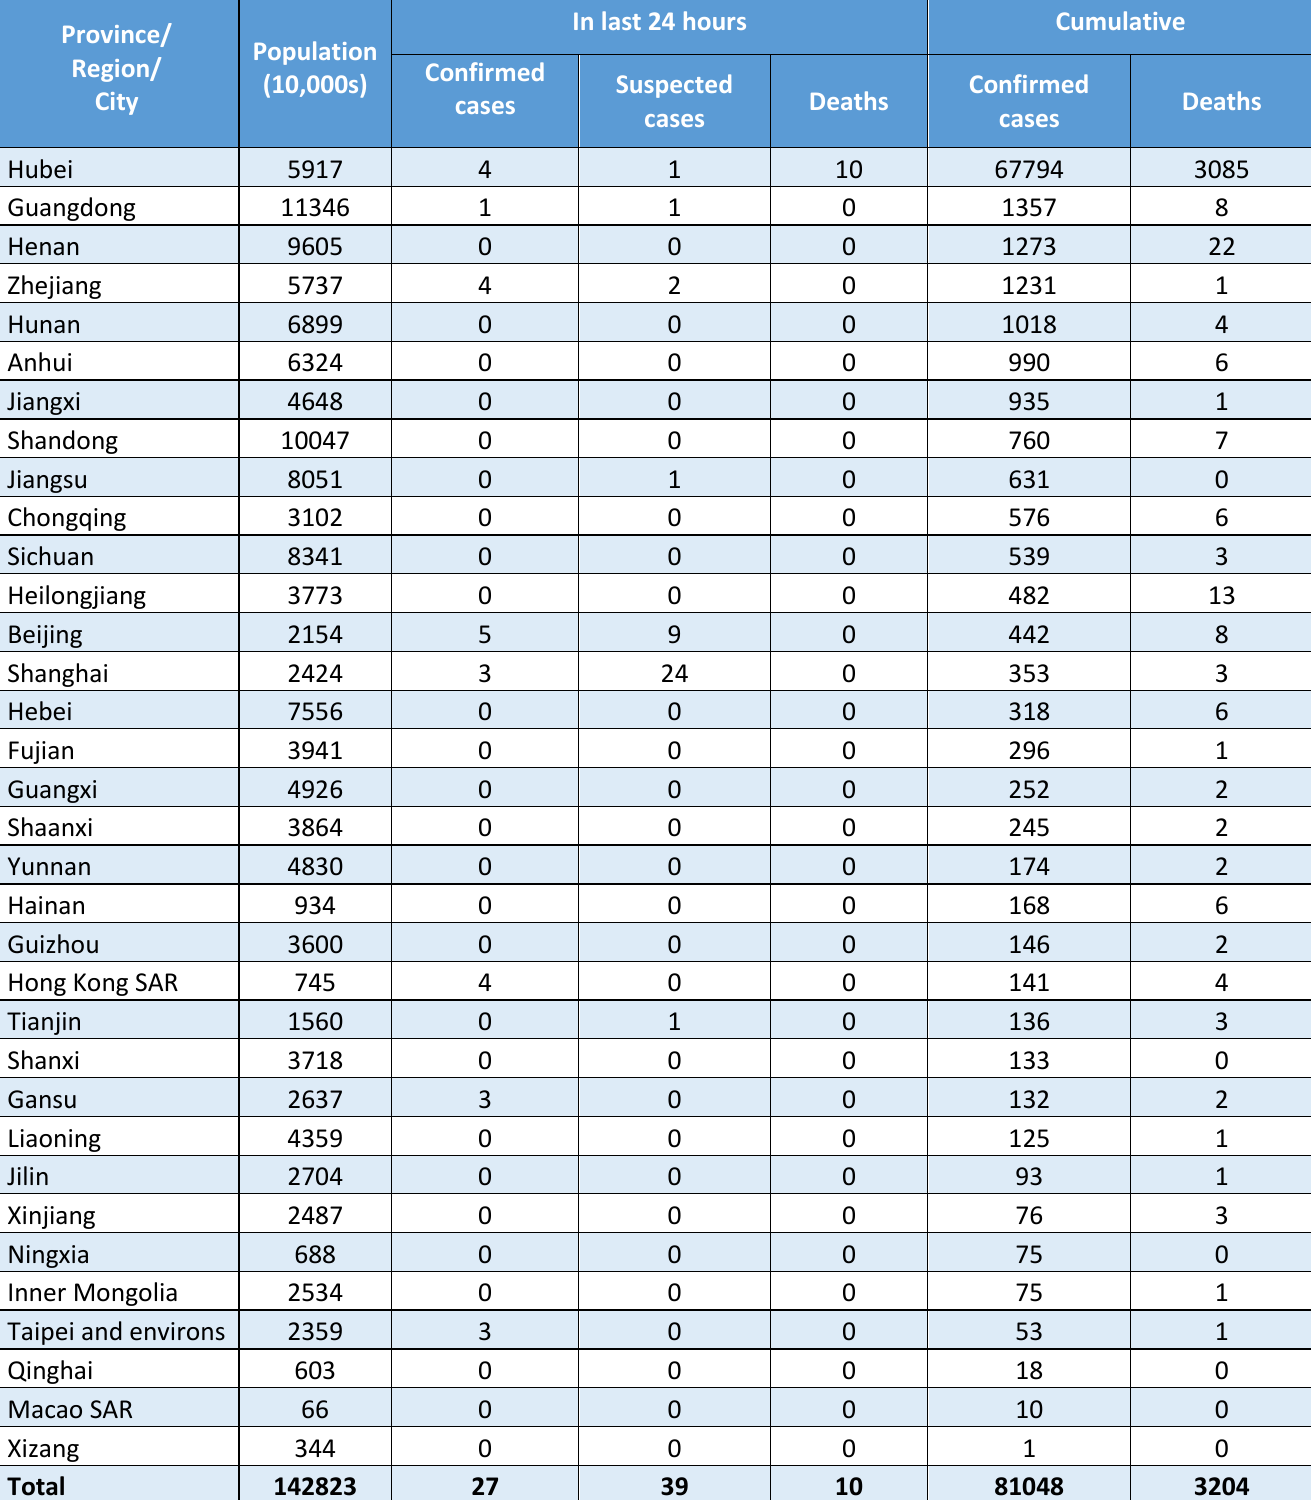
Table 1. Confirmed and suspected cases of COVID-19 acute respiratory disease reported by provinces, regions